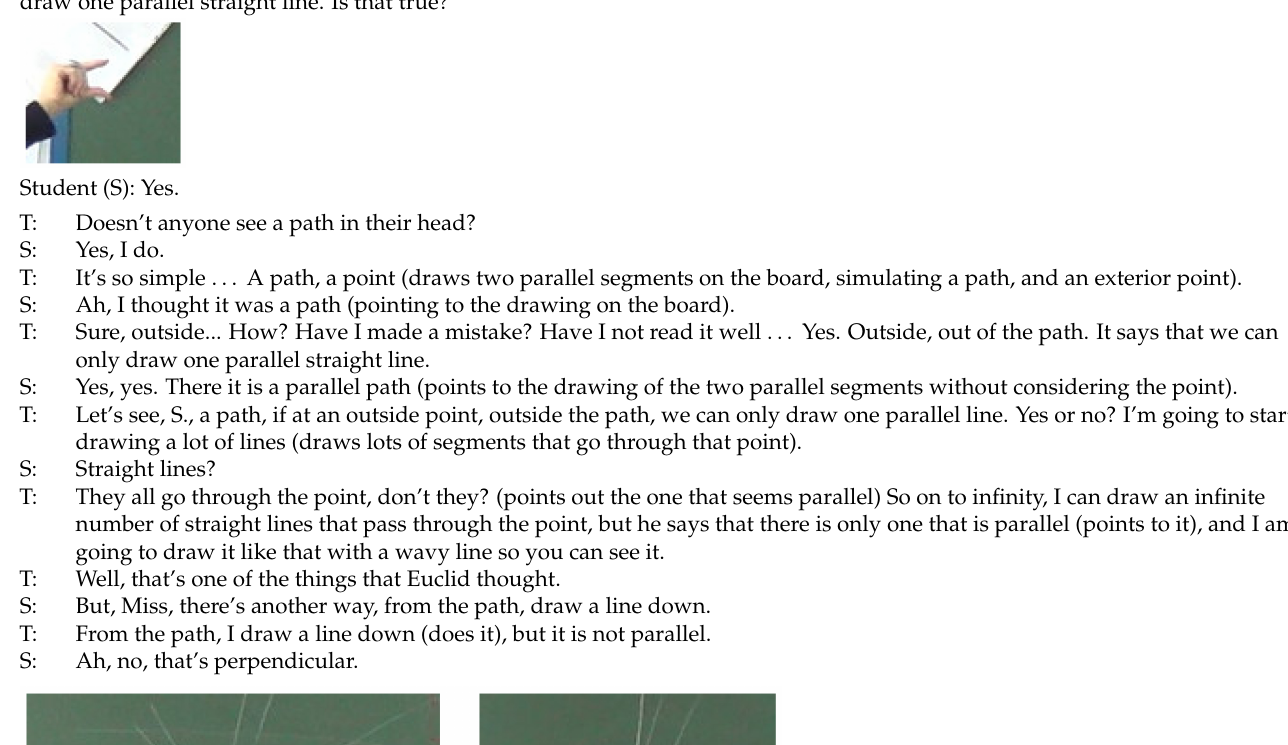
Table 3. Part of the transcript of the first lesson on